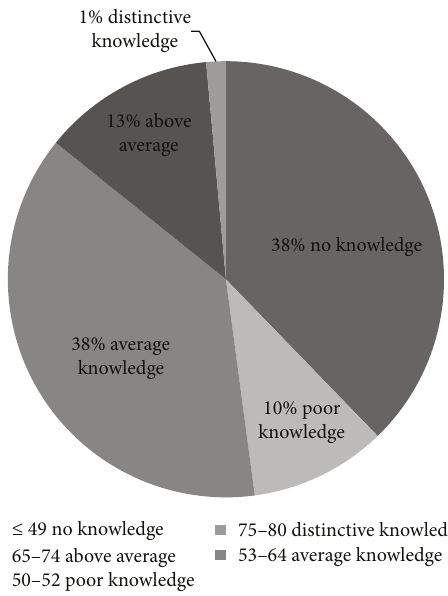
Figure 1: Level of knowledge and awareness of